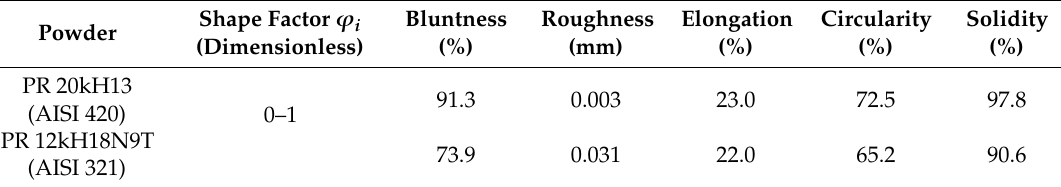
Table 3. Shape parameters of the powders according to EN ISO 9276-6; 7; 8.